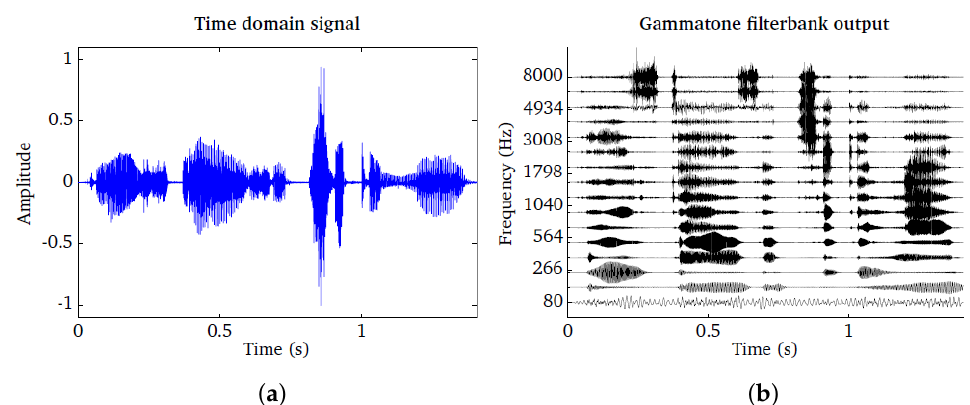
Figure 3. ( a ) Time domain signal. ( b ) The corresponding output of